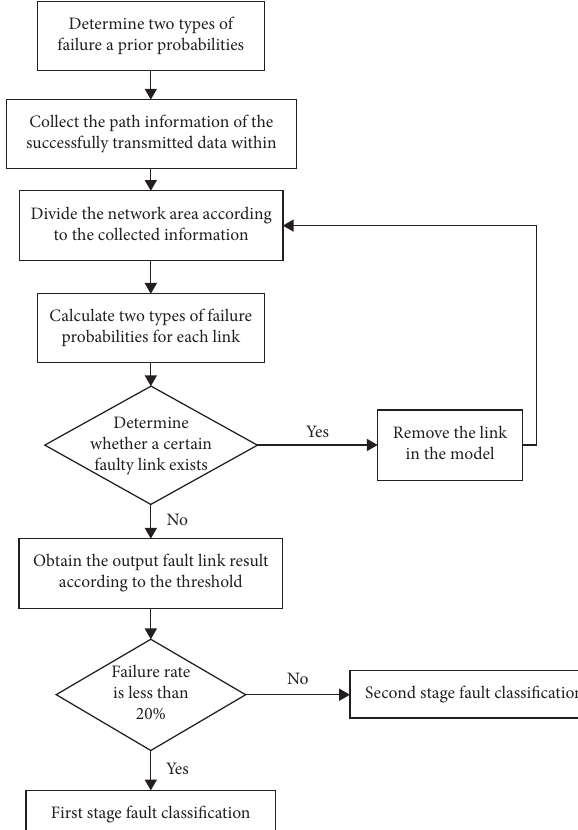
Figure 1: The schematic diagram of fault detection